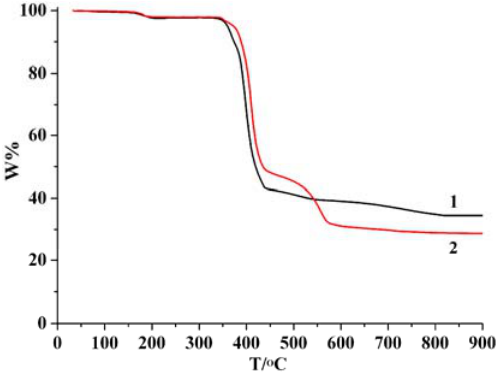
Figure 3. TGA curves for compounds 1 and 2